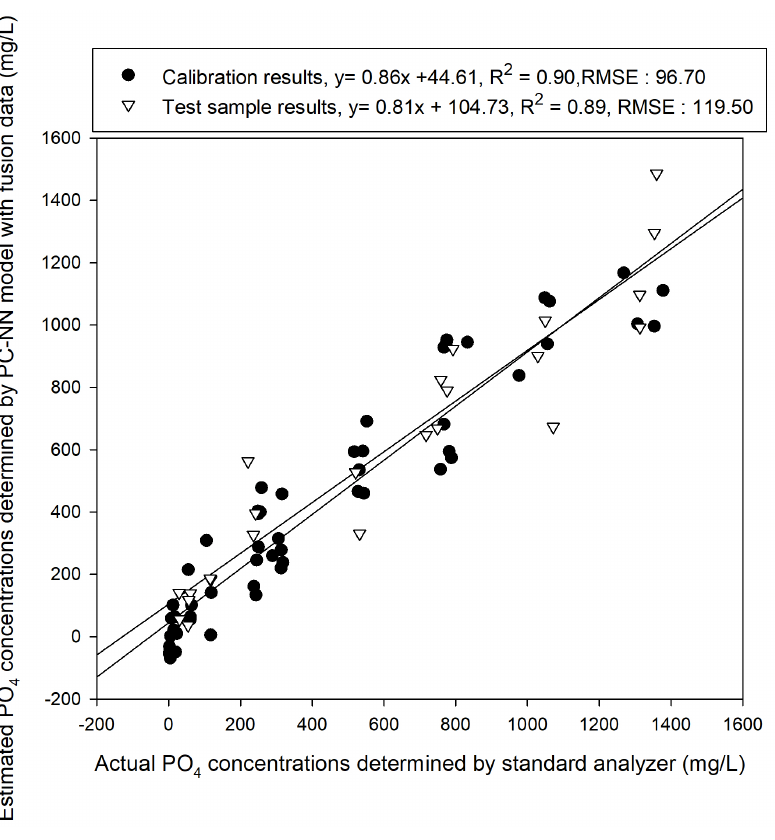
Figure 12. Prediction results of the test samples and calibration model developed using a PC-NN